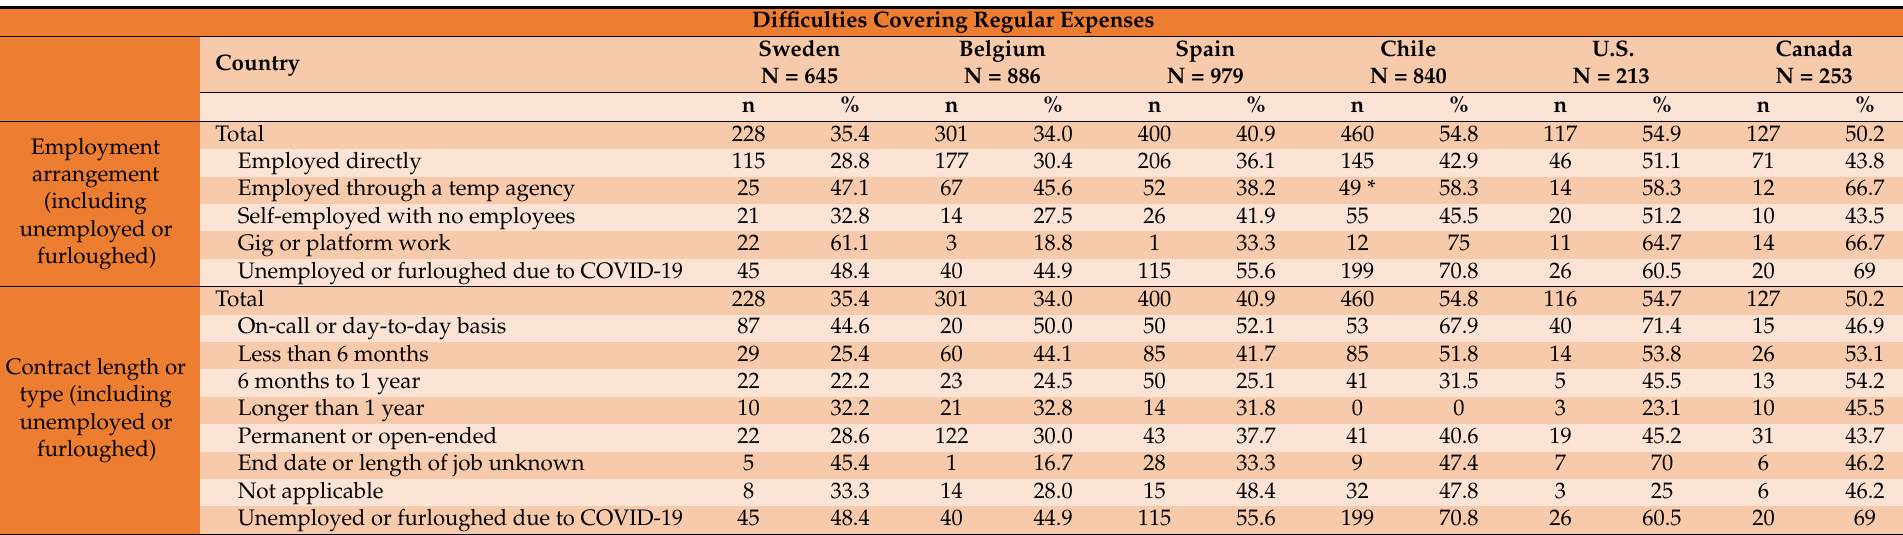
Table 4. Proportion of respondents who had difficulties covering regular expenses at least several times during the three months prior to survey completion, by employment arrangement, length or type of contract, and by